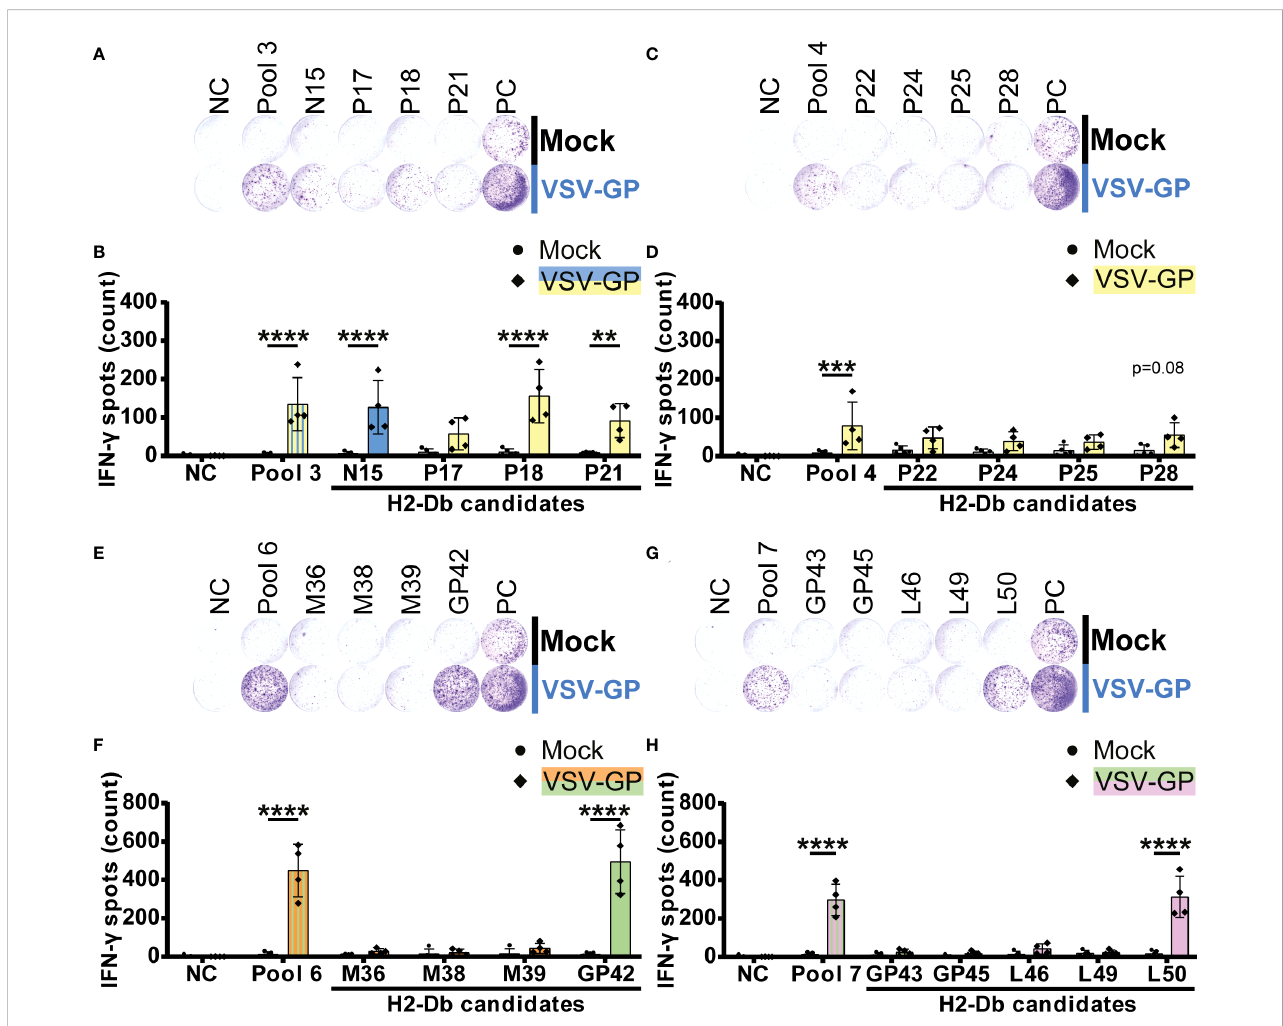
FIGURE 3 H2-Db individual peptide testing using IFN- g ELISpotidenti fi es H2-Db presented VSV-GPT cellepitopes. (A,C,E,G) Representative images ofIFN- g ELISpots using2.5 x 10 5 splenocytes perwell uponstimulation with 35 µg/ml peptide pool or 5 µg/ml individual peptide.The negative control(NC) is unstimulated cells, and the positive control (PC) is 5 µg/ml ConA. (B,D,F,H) Quanti fi cation ofIFN- g ELISpots (n=5for mock, n=4 for VSV-GP, fromtwo